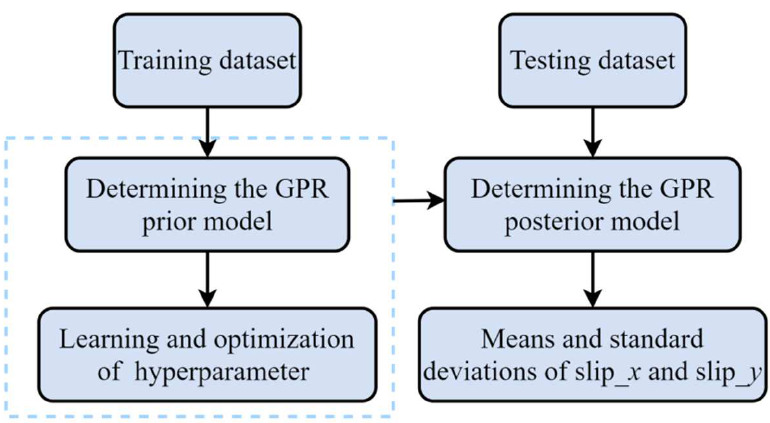
Figure 7. Flowchart of the model establishment process using GPR.